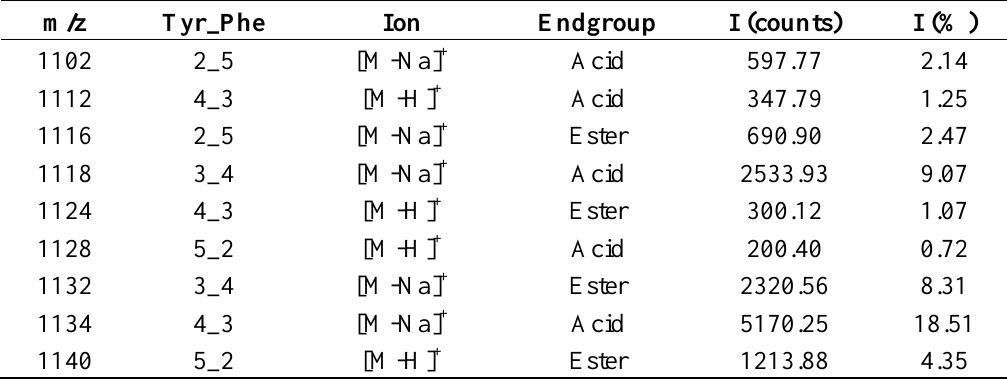
Table 4. Identification of the ions found in the poly(Tyr-co-Phe)